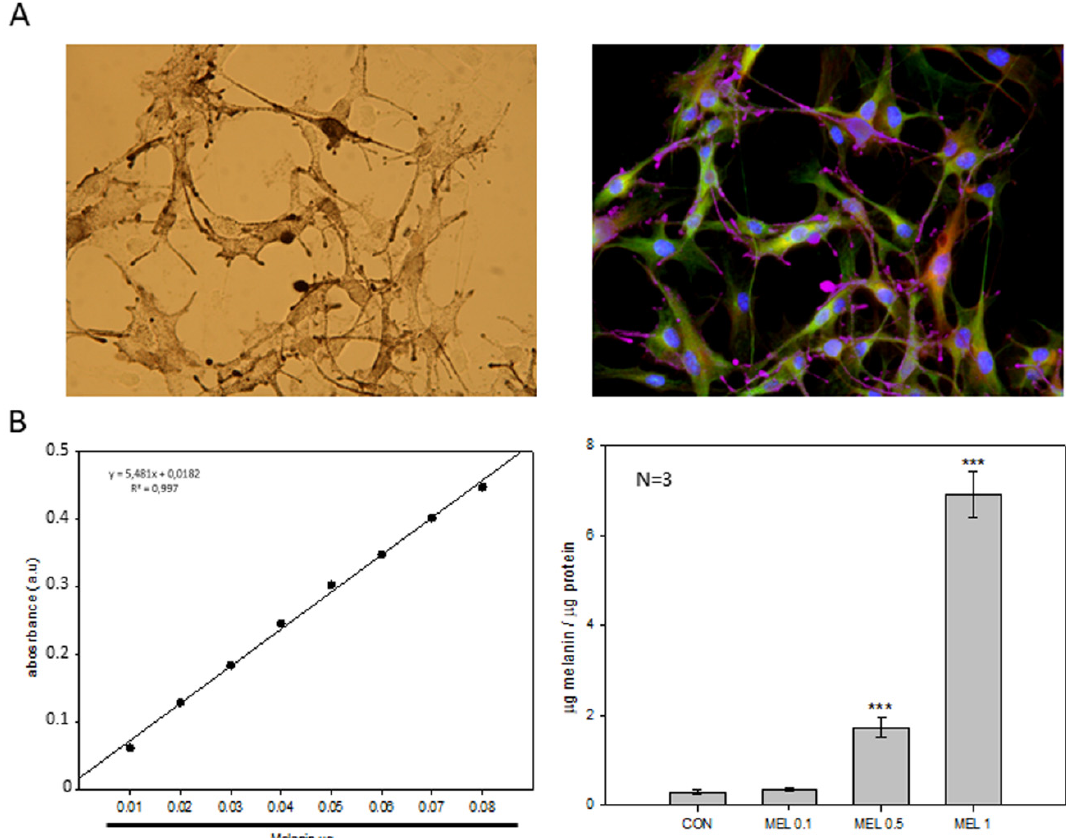
Figure 6. Melanin localization and quantification in B16-F10 cells. ( A ) Phase-contrast micrographs of intracellular melanin depots (left) and the corresponding merge with α -tubulin and β -actin distribution (right). Micrographs were both taken at a final magnification of 200 × . ( B ) Quantification of total intracellular melanin after treatment with different concentrations of Melatonin. Data were shown as average +/ − SEM. Significance vs. CON. *** P < 0.001